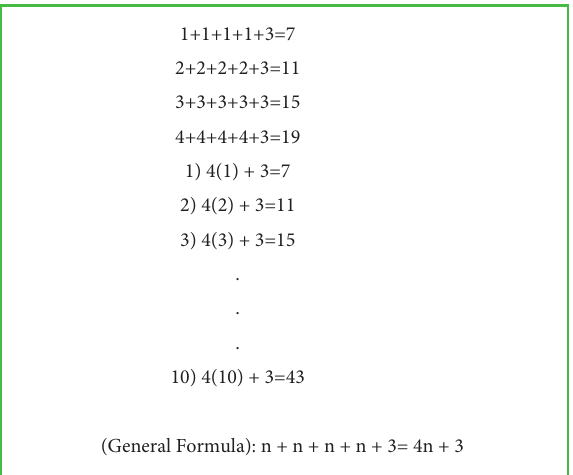
Figure 6: Concluding formula of S1 subject in formulating